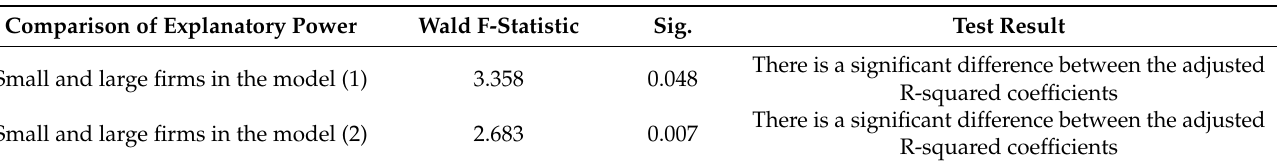
Table 16. Survey of the significance of the difference in the adjusted R-squared coefficient of the regressions according to the firm size in the first and second hypothesis (Wald